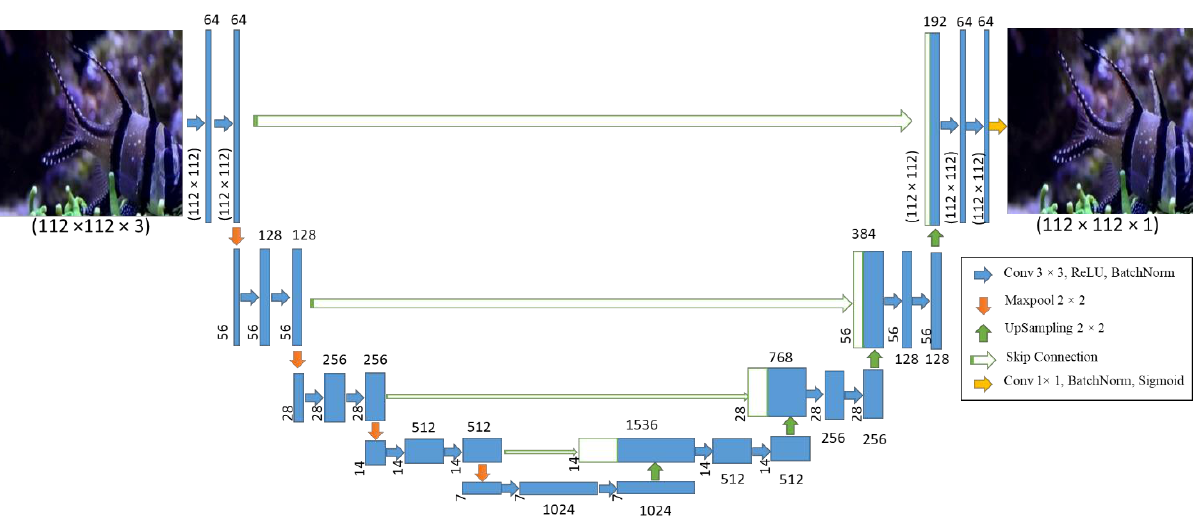
Fig. 1. Autoencoder for Underwater image feature extraction .